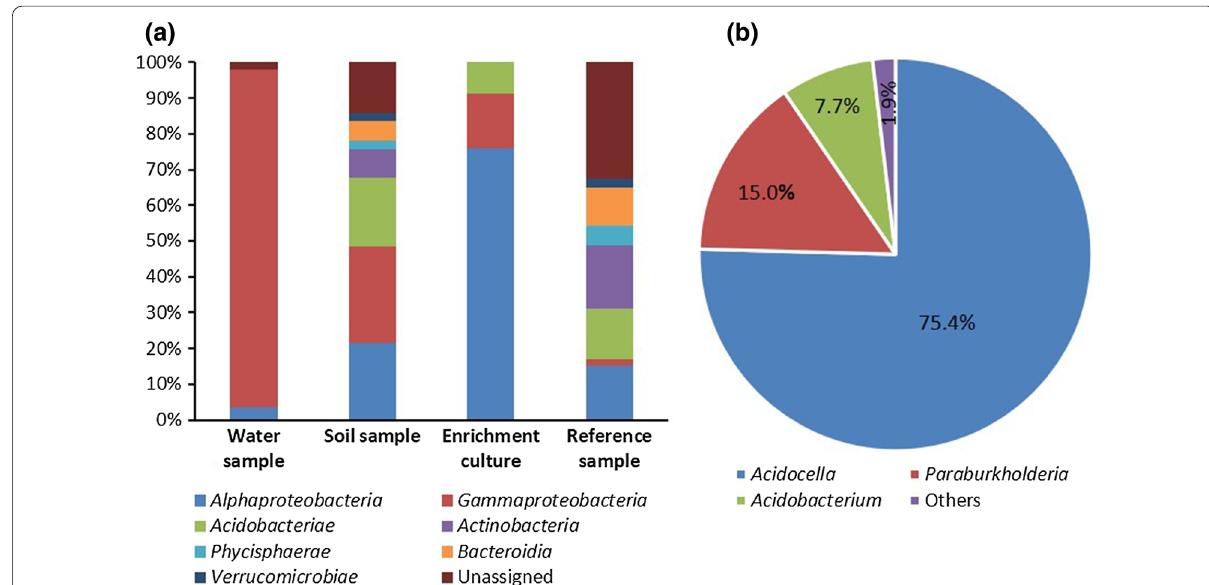
Fig. 3 a Bacterial community composition in selected water, soil, enrichment, and unpolluted reference samples. b Relative abundance of the enrichment culture at the genus level. Only taxa with a relative abundance of > 1% across all samples are presented. For details on relative abundances and 16S rRNA gene amplicon data, see Additional file 1: Fig.